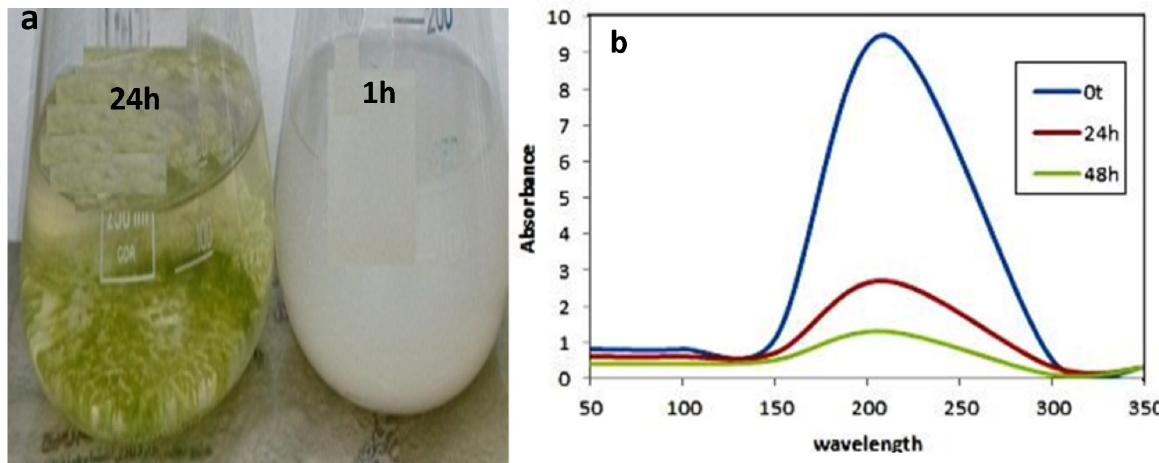
Figure 4. (a ) Interactions between TiO NPs and S. platensis biomass after 1h and 24 h incubation periods, ( b ) UV- 2 Vis absorption spectrum of TiO after adding S. platensis culture after 0 h, 24 h and 48 h of incubation 2